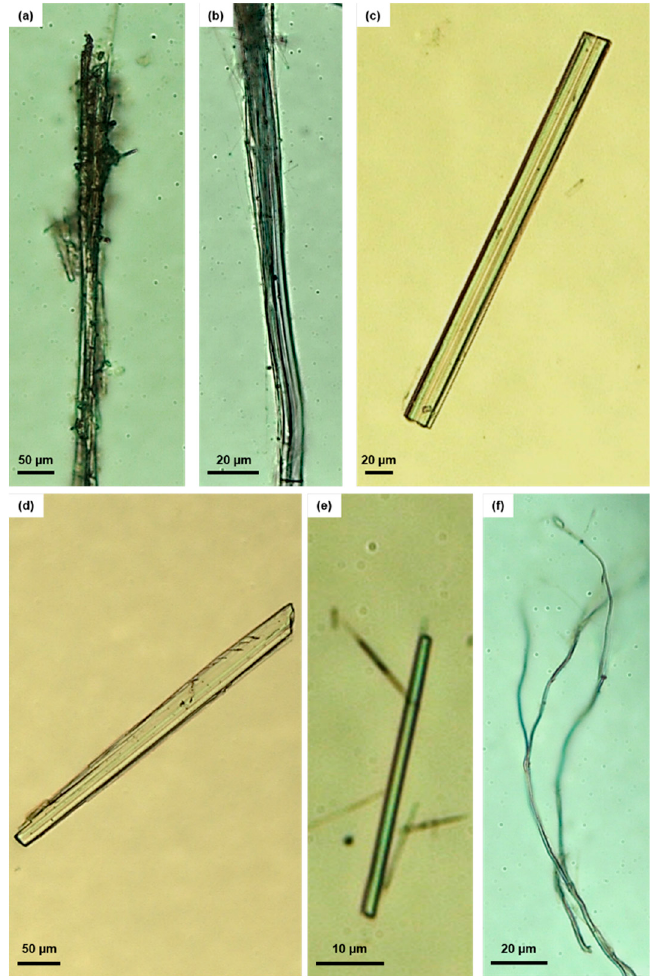
Figure 2. Optical Microscopy images of the six regulated asbestos minerals: ( a ) amosite; ( b ) crocidolite; ( c ) tremolite; ( d ) anthophyllite; ( e ) actinolite; ( f ) chrysotile.